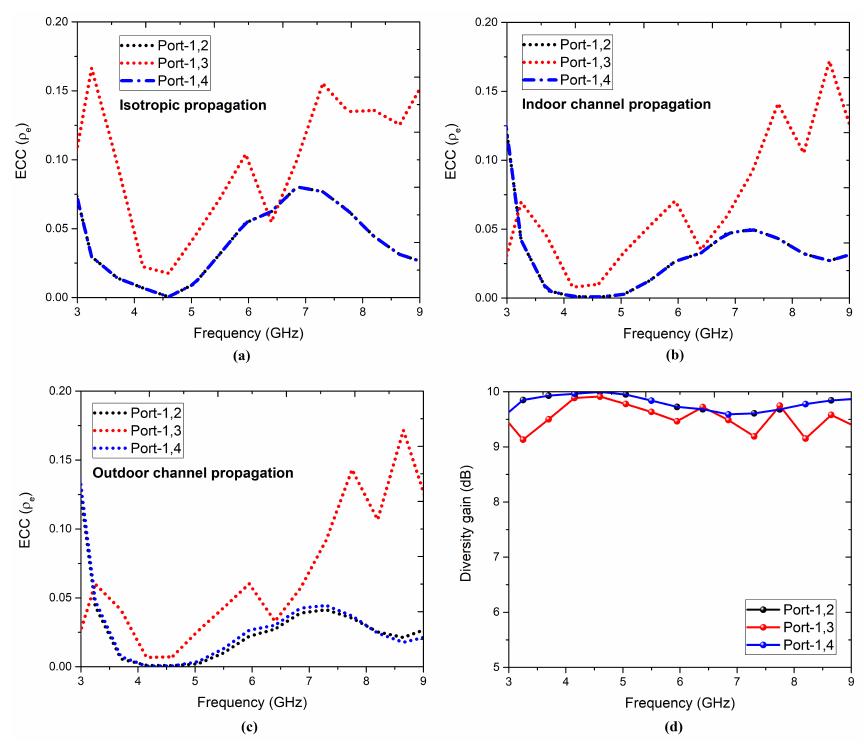
Figure 23. ( a ) ECC for isotropic, ( b ) ECC for indoor, and ( c ) ECC for outdoor environments (propaga- tion), and ( d ) diversity gain of the four-element antenna